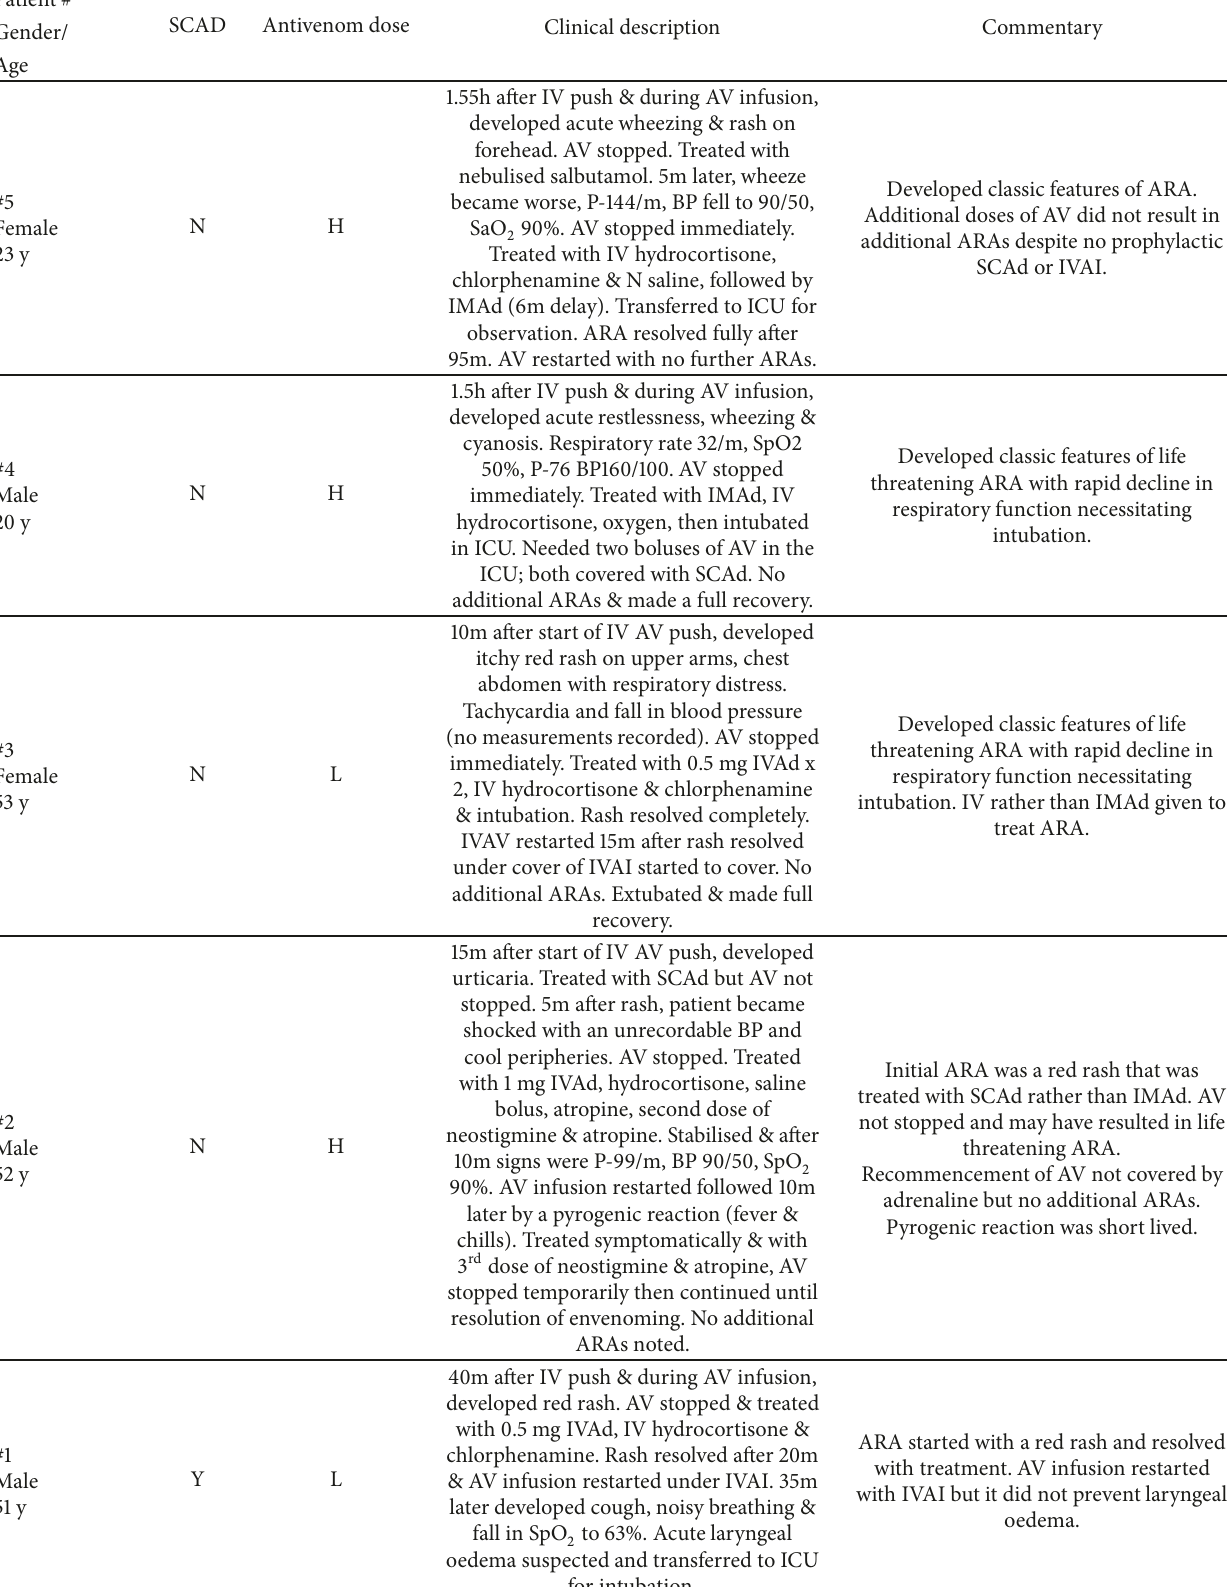
Table 4: Clinical notes on the five patients with neurotoxic envenoming who survived. Patient #